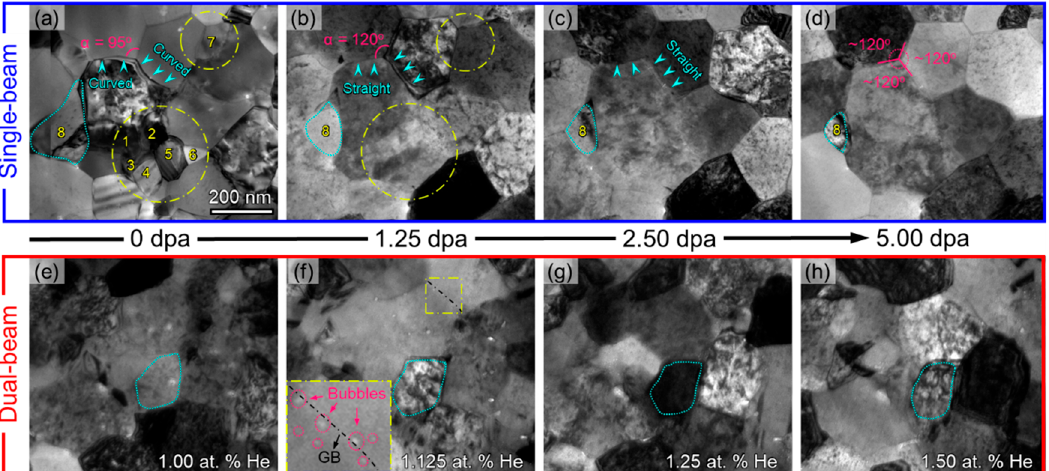
Figure 2. In situ TEM snapshot displaying microstructural evolution of NC Cu under single-beam ( a – d ) and dual-beam irradiation ( e – h ). GB migrations were frequently captured in single-beam irradiation and grain coarsening occurred at the expense of small grains, as evidenced by the shrinkage of several tiny grains marked by number 1–8 in ( a – d ). The arrows in ( a ) mark the curved GBs for a large grain that became straight with increasing dose in ( b , c ). In contrast, the grains under dual-beam irradiation only experienced slight rearrangement of their geometries, as shown by the dotted lines in ( e – h ).